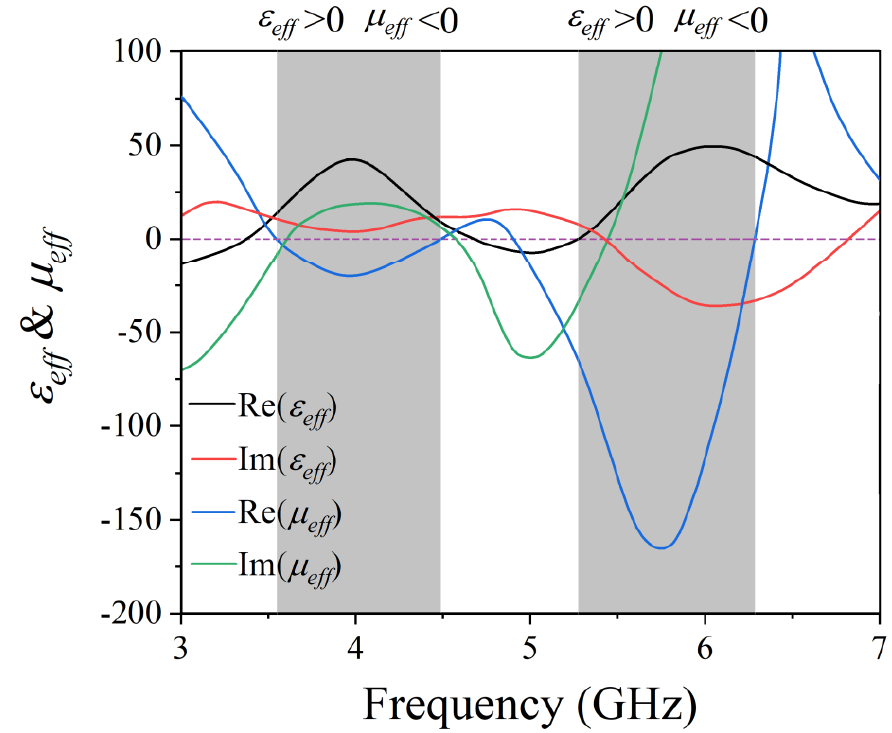
Figure 4. The effective permeability ( µ eff ) and permittivity ( ε eff ) of the AMC unit cell where the black (blue) lines denote the real part of ε eff ( µ eff ) and the red (green) line denotes the imaginary part of ε eff ( µ eff ).